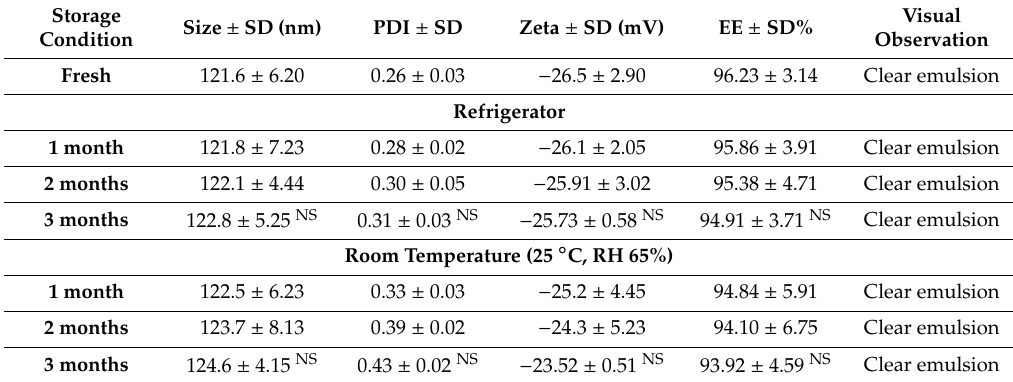
Table 2. Storage stability study of CC-NLC; NS : Not significantly di ff erence at p > 0.05.